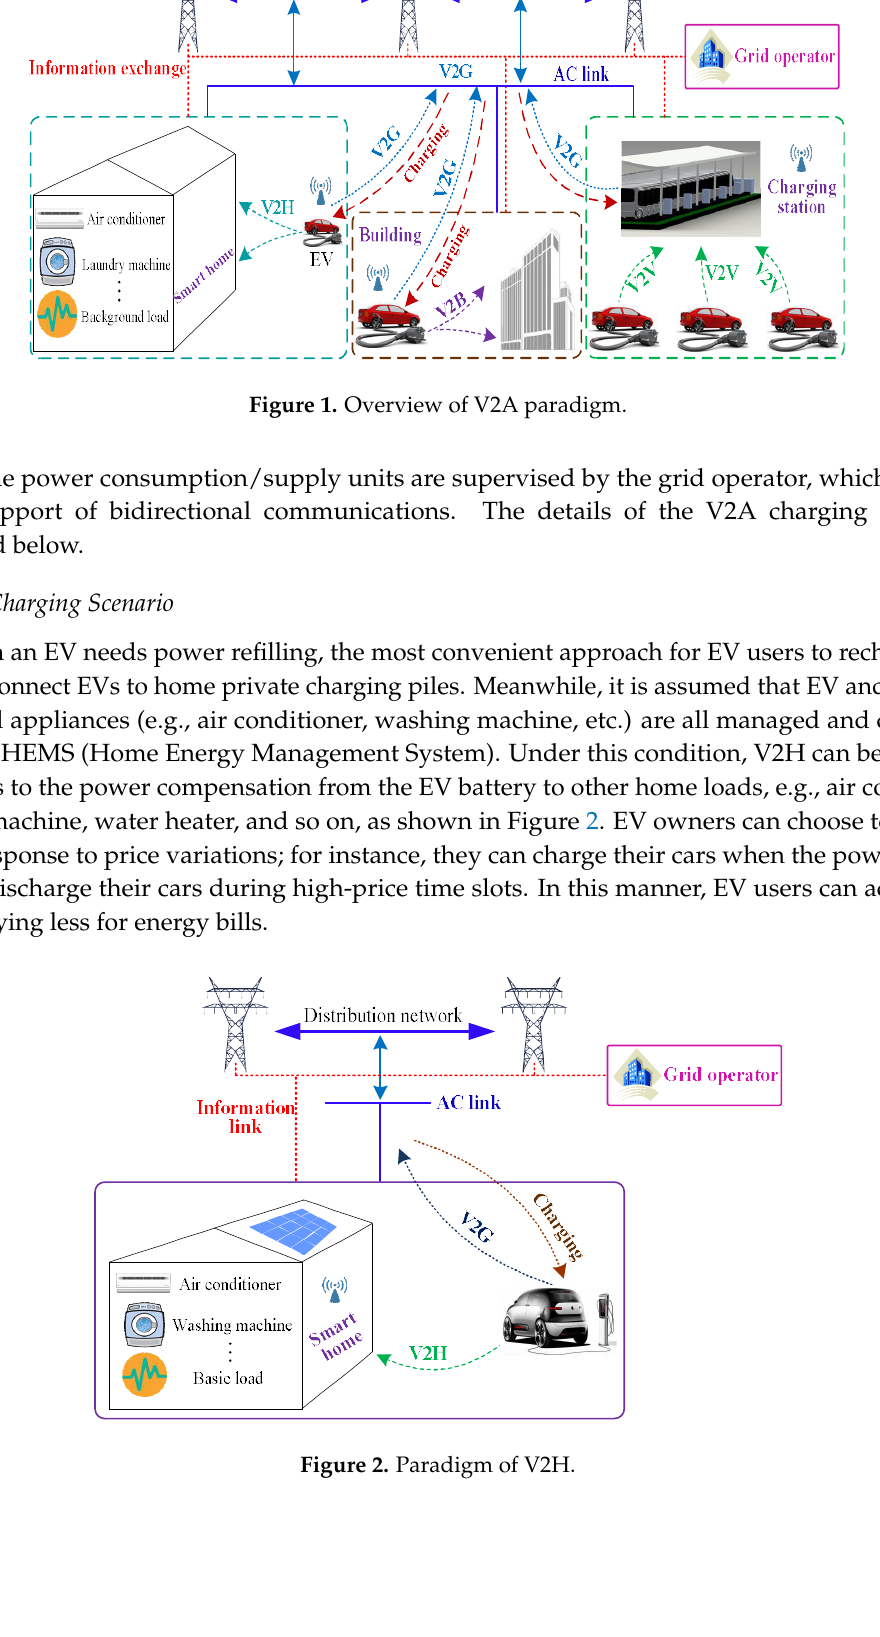
Figure 2. Paradigm of V2H.